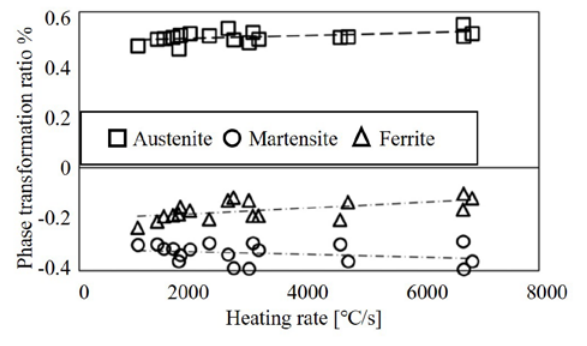
Fig. 4. Effects of heating rate on phase transformation.